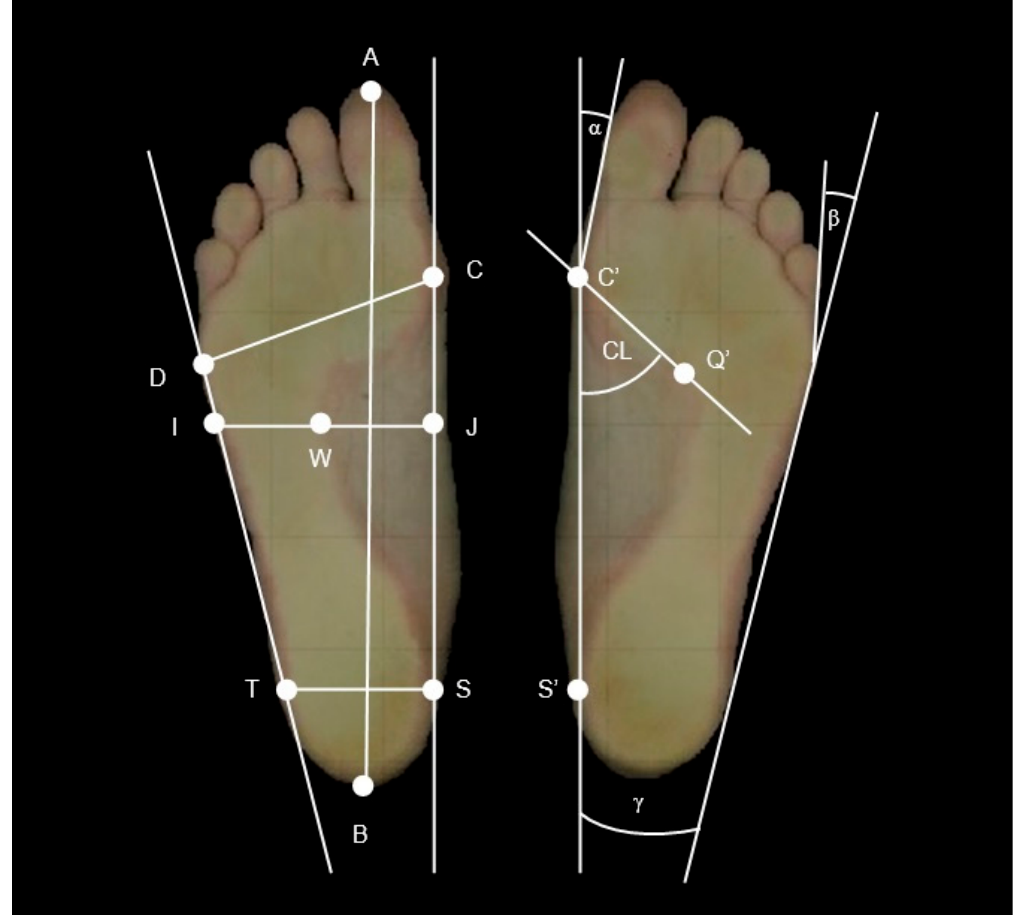
Figure 1. Graphical visualization of the determined parameters: Clarke’s index (CL), Sztriter– Godunow index (KY), Wejsflog index (W), heel angle ( γ ), hallux valgus angle ( α ), and varus of the fi fth toe ( β ).